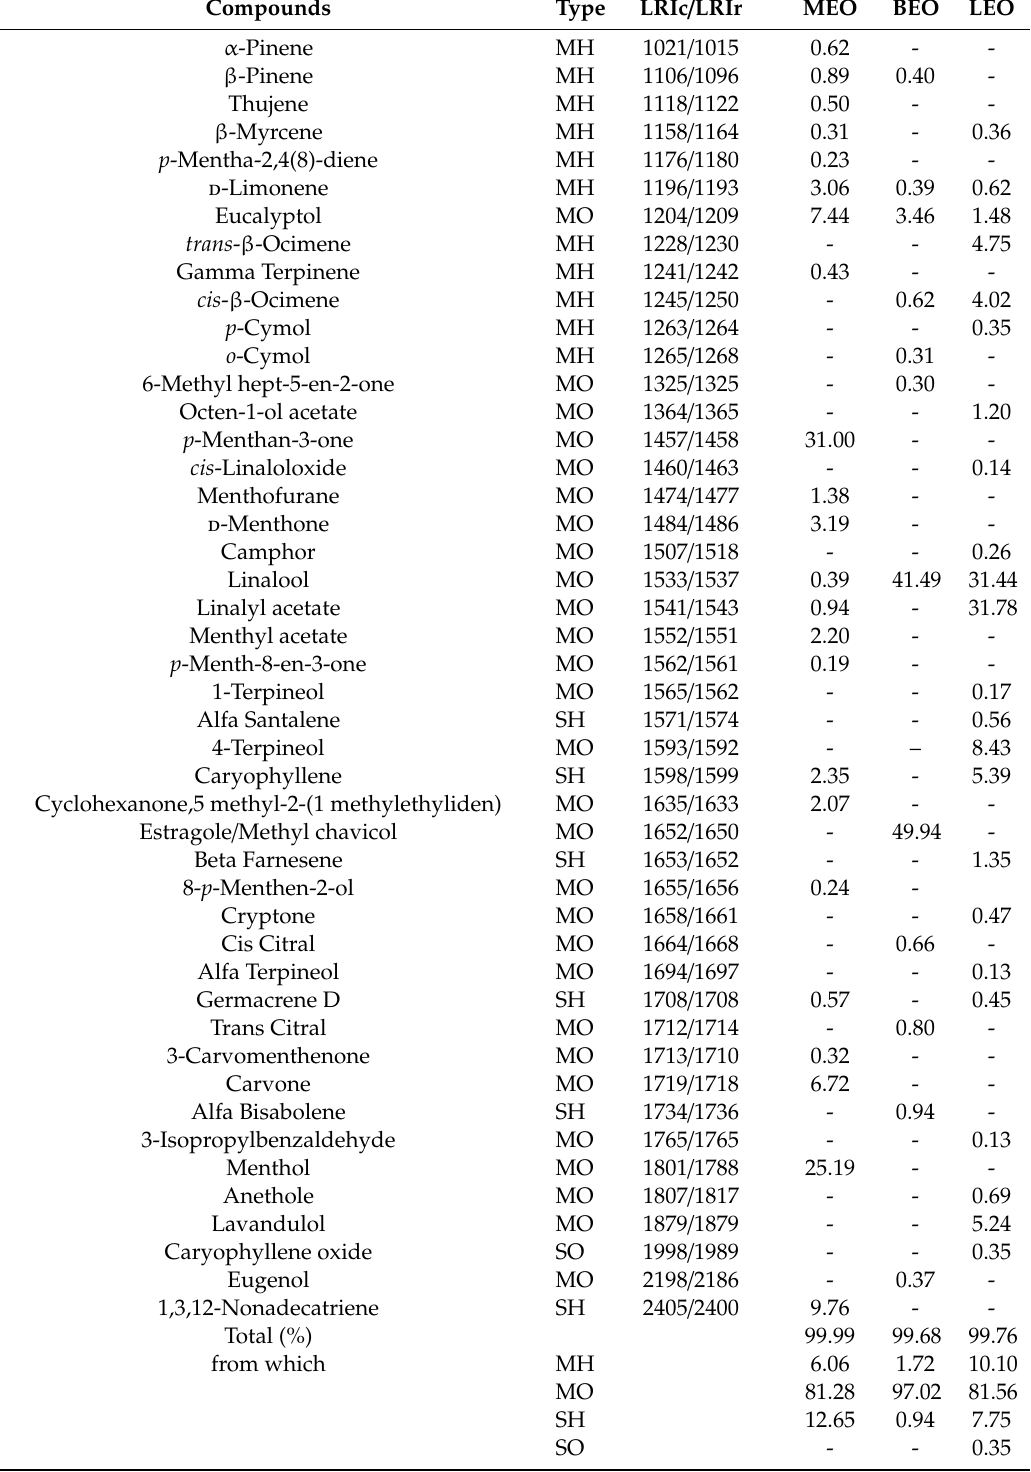
Table 1. The chemical composition of essential oils, GC / MS analysis (% from total compounds).